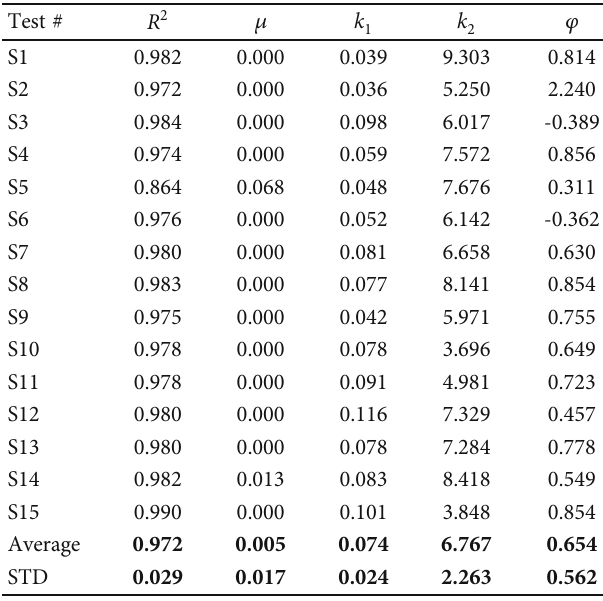
Table 3: Estimated material parameters of porcine sclera soft tissue loaded biaxially using Choi-Vito hyperelastic constitutive model including the coe ffi cient of determination ( R 2 ) of each specimen ( N = 15 ). The average constitutive ( c , b 1 , b 2 , b 3 , and R 2 ) parameters are also included.